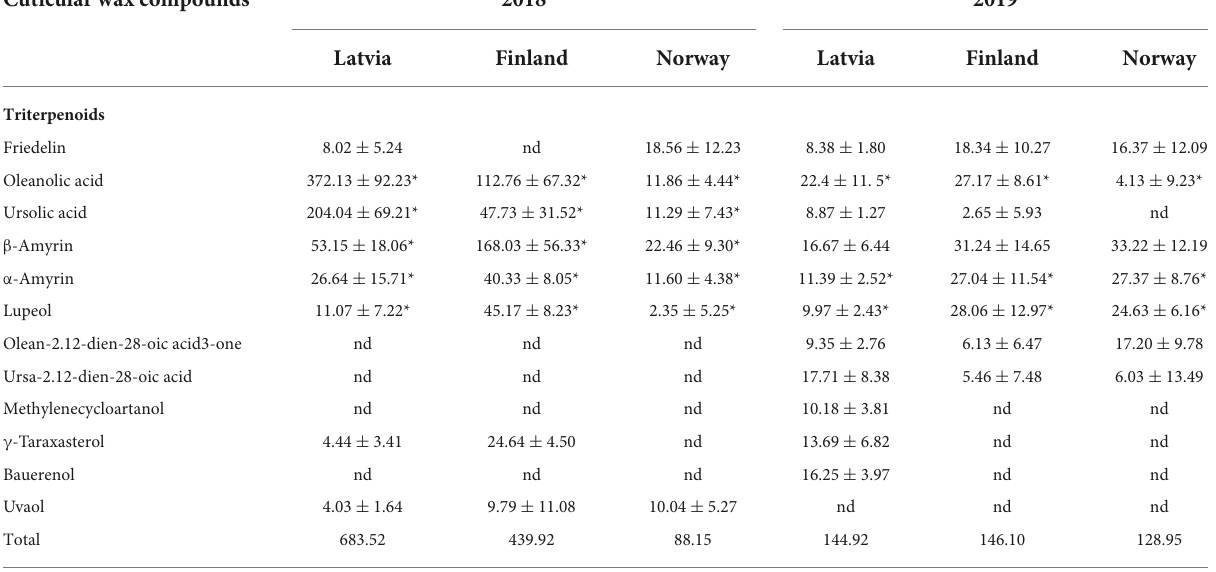
TABLE 1 Quantities ( µ g/mg of berry cuticular wax) of triterpenoids in ripe bilberry wax through a latitudinal gradient. Cuticular wax